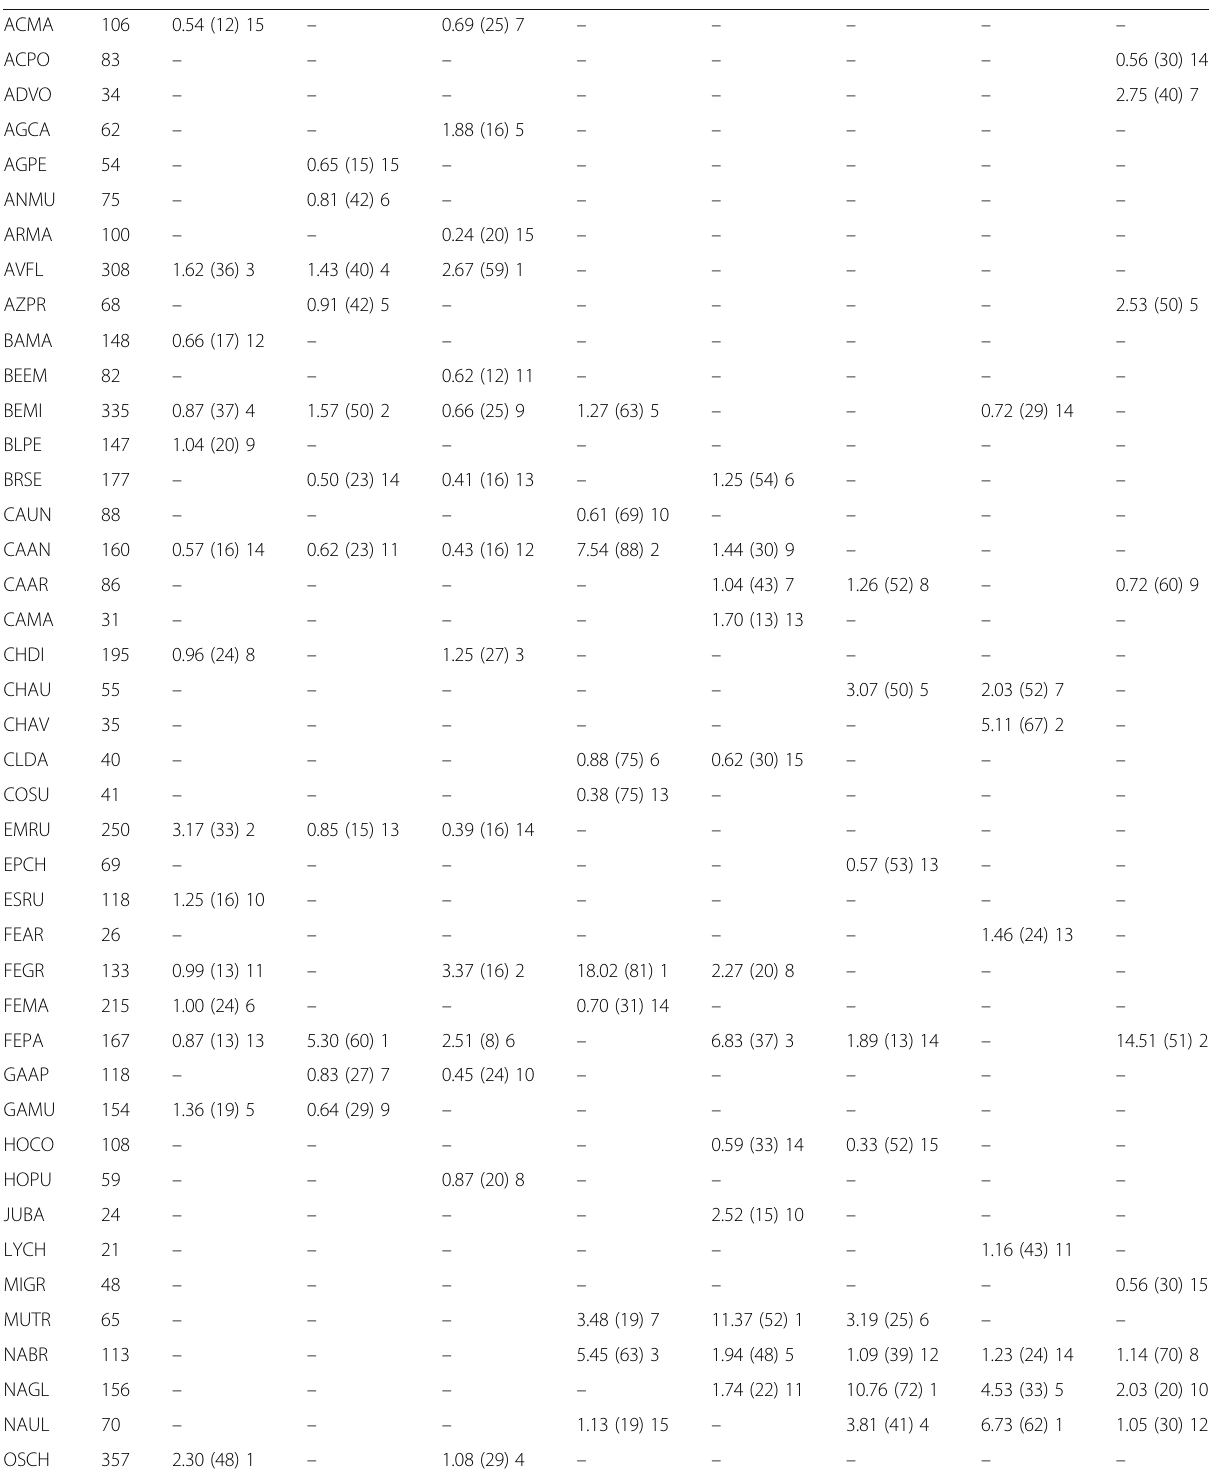
Table 1 Code for vascular plant species, number of presence point ( N ), mean cover (%), and frequency of occurrence (%) between brackets, followed by the rank (1 to 15) for the most important species of each ecological area ( FAV forests and alpine vegetation, SAG sub-Andean grasslands, HMGS humid Magellanic grass steppes, DMGS = dry Magellanic grass steppes, SL shrublands, CP central plateau steppes, SSJG shrub-steppes of San Jorge Gulf, MP mountains and